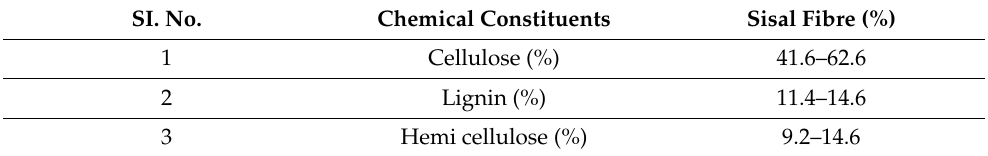
Table 2. Chemical composition of sisal fibres